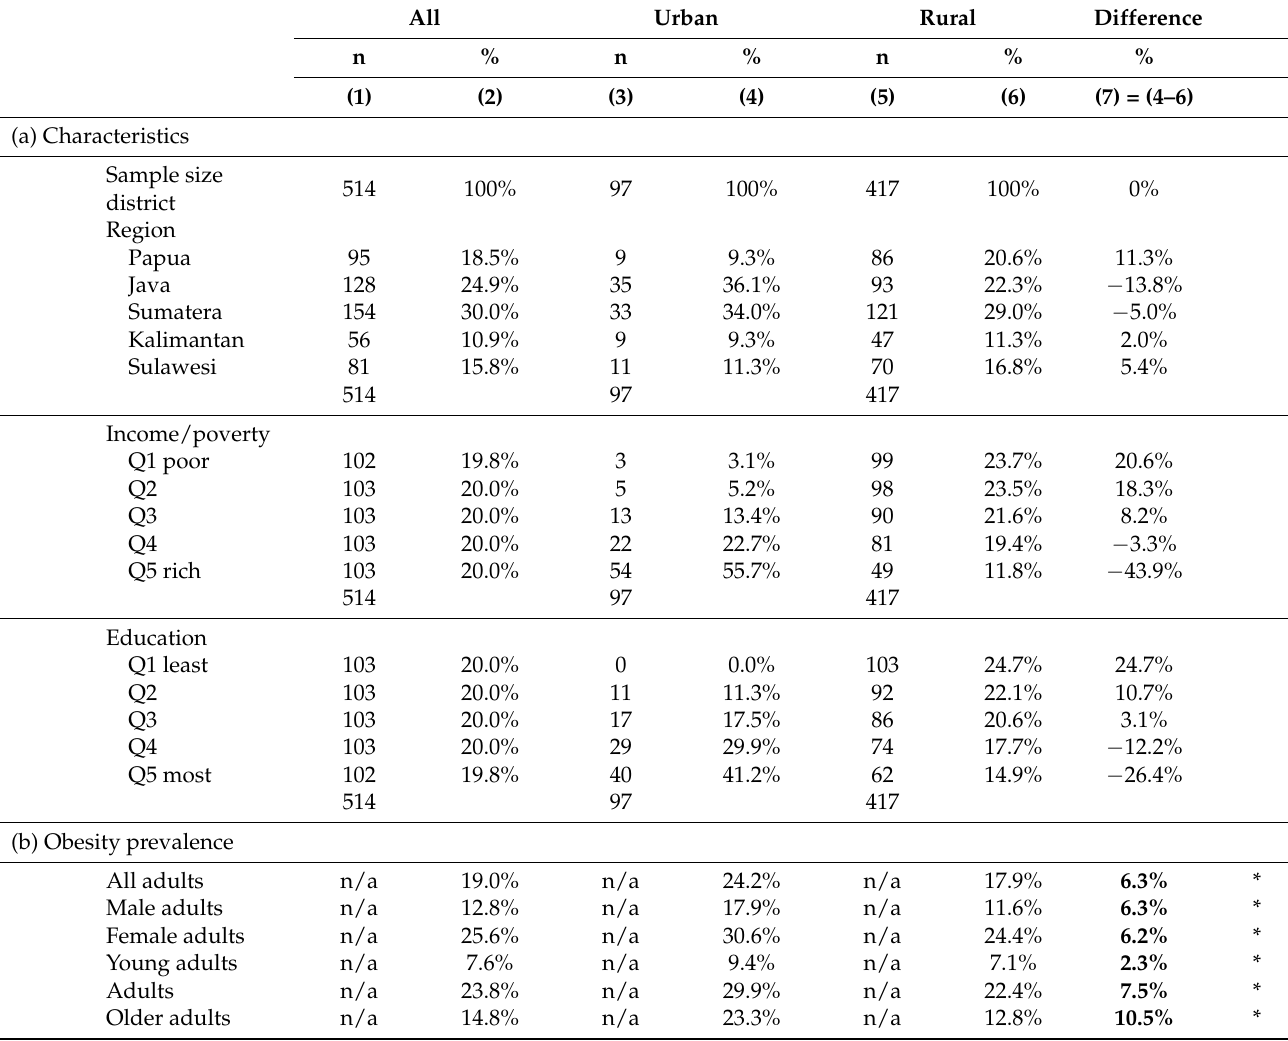
Table 2. Characteristics of districts and obesity among